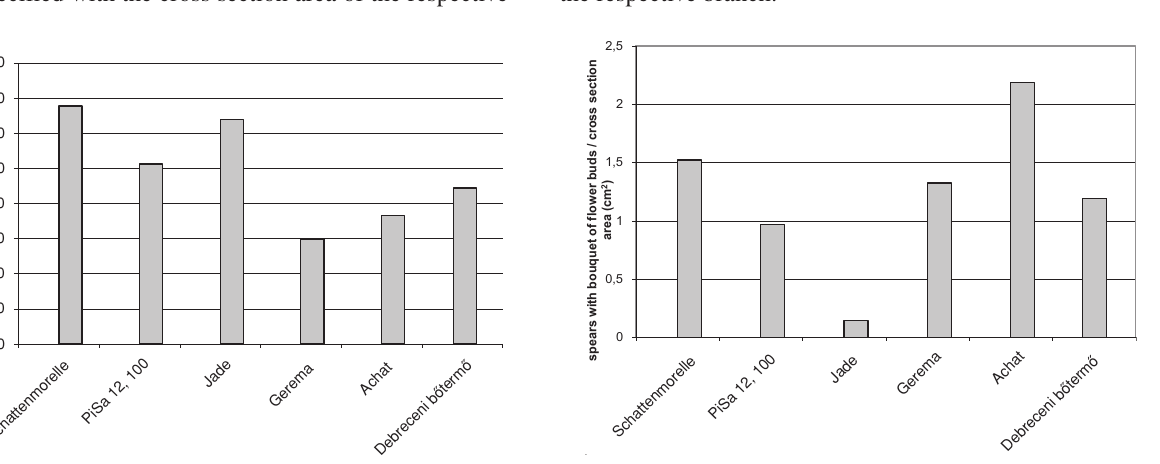
Figure 3. The number of bouquets of flower buds related to the cross section areas ( Debrecen-Pallag,